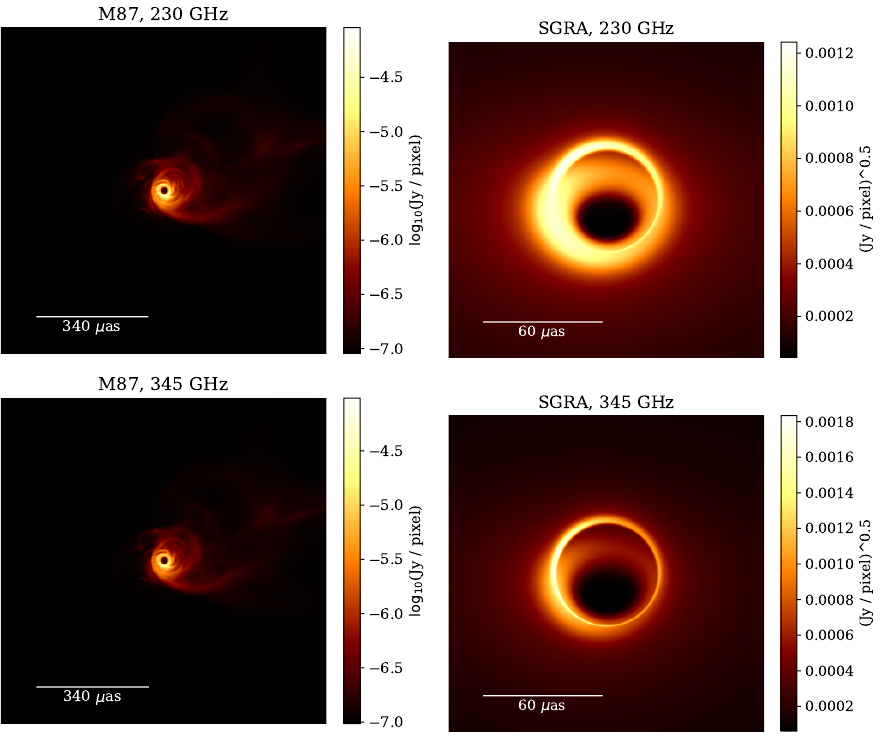
Figure 1. Source models used for Challenge